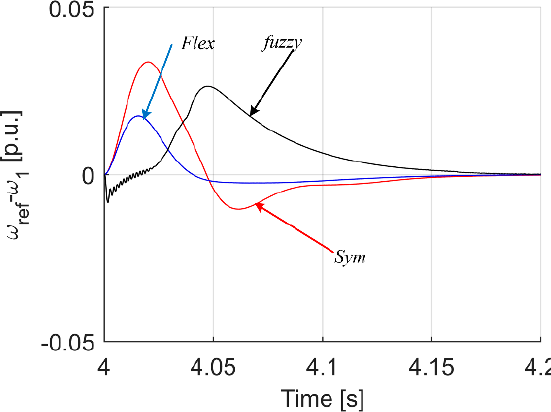
Figure 24. Transients of difference between motor and reference speed for case of reference speed change. To be clear, Figures 15 and 25 show the process of adaptation. At the same time, as mentioned in Section 4.2 for each system, a series of adaptations with different scopes of variable searches. It should be noted, however, that each of the sets (specific constraints and specific cost function) were run for both algorithms. Moreover, the reproducibility function allows to guarantee the fairness of such a comparison (each algorithm was opti- mized for the same parameters). As a result, it turned out that the best quality was ob- tained with the optimization of the fuzzy controller with the first type functions for con- straints k em (0–10) k Δ m (0–20) while for the controller with type II functions for constraints were k em (0–10) k Δ m (0–10).